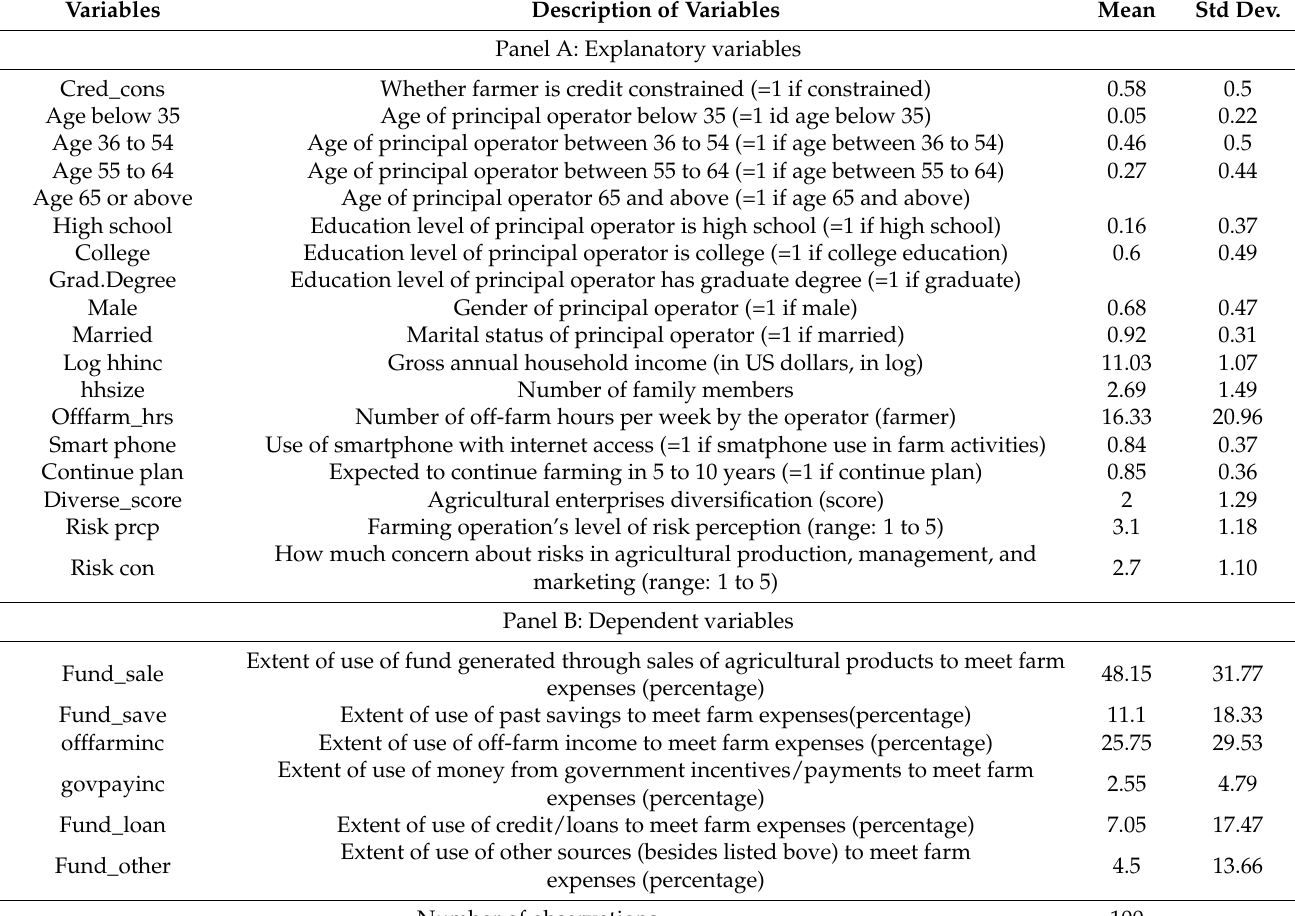
Table 1. Summary statistics of variables used in the